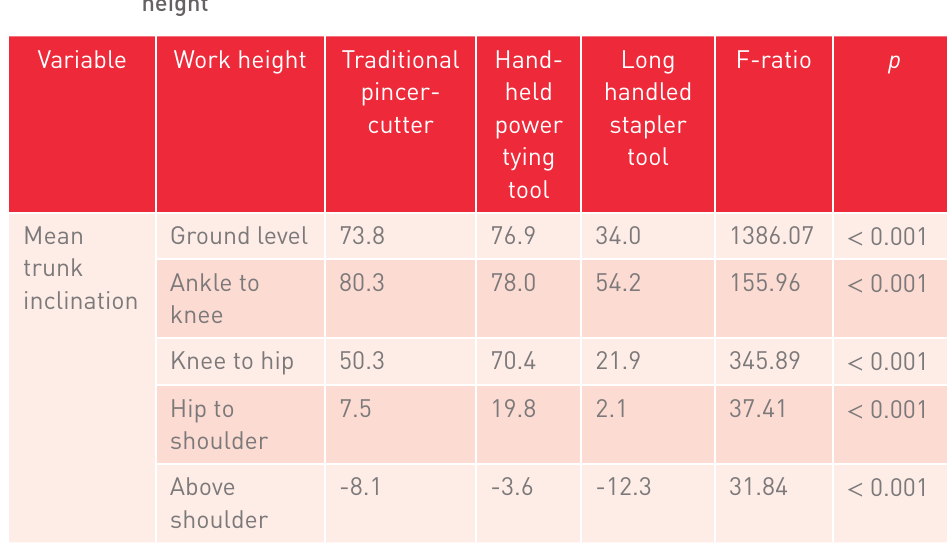
Comparison of mean trunk inclination measurements by tool for each